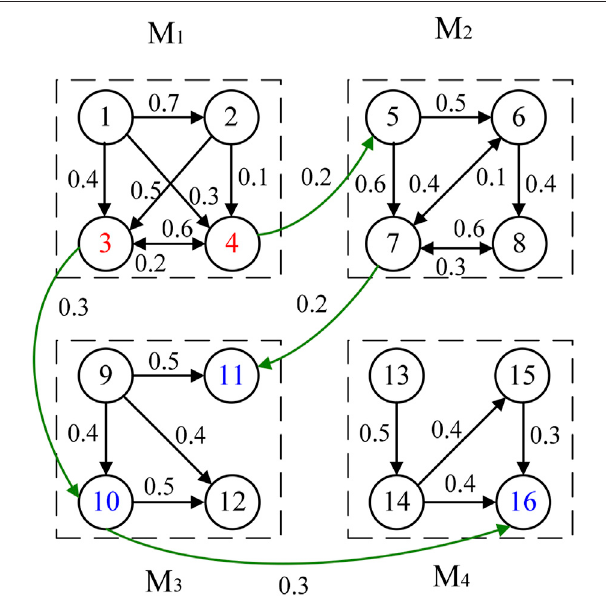
FIGURE 6 | Change propagation network between